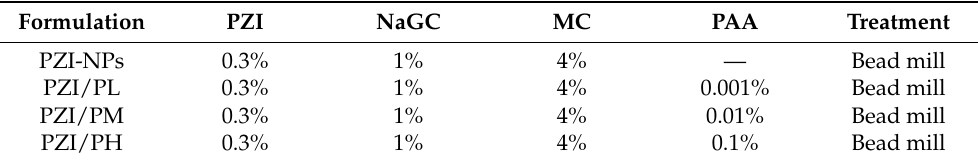
Table 1. Compositions of INS ophthalmic